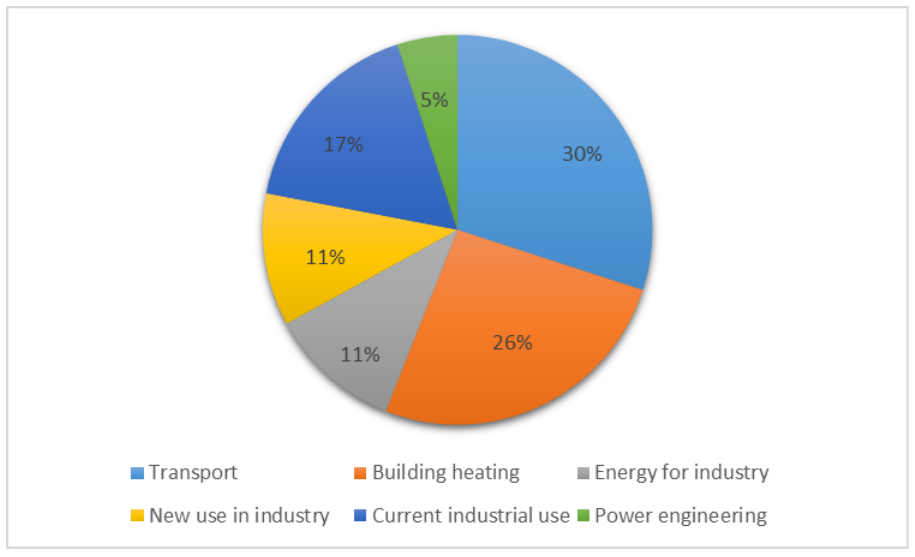
Figure 6. The use of hydrogen in 2050 in an ambitious scenario [58].